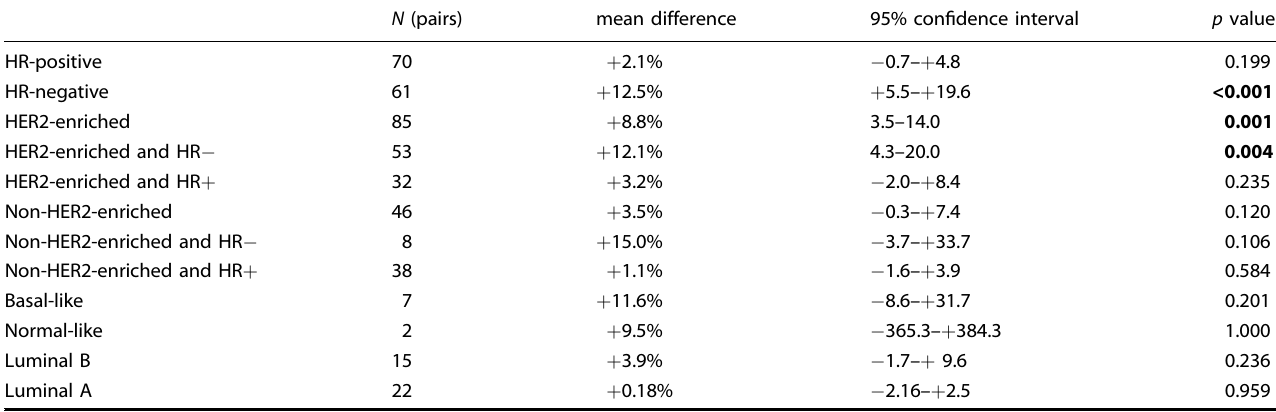
Table 2. Changes in TILs between day 15 and baseline according to PAM50 intrinsic subtype and hormone receptor (HR)